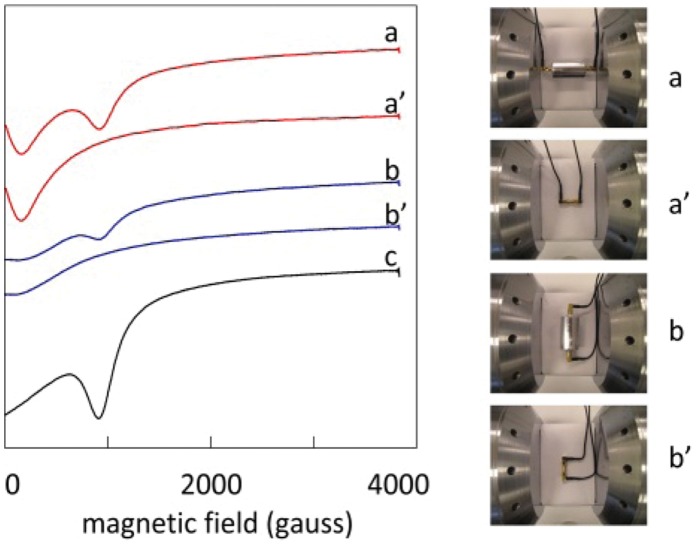
Transmission EPR of solid MnSO4⋅H2O in a 42 mm standard cell.Traces a and a’ are for TEM || B orientation, and traces b and b’ are for TEM ⊥ B. The primed traces a’ and b’ are baselines from short-circuited leads without transmission cell. Trace c is for the 82 mm aluminum cell in TEM || B orientation.